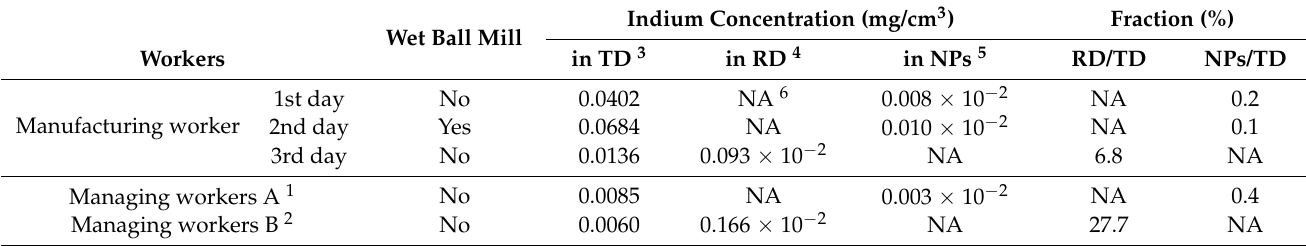
Table 1. Indium concentrations and fraction (%) of respirable dust and nanoparticles (NPs) in workers’ personal samples. Indium Concentration (mg/cm 3 ) Fraction (%) Wet Ball Mill Workers Manufacturing worker Managing workers A